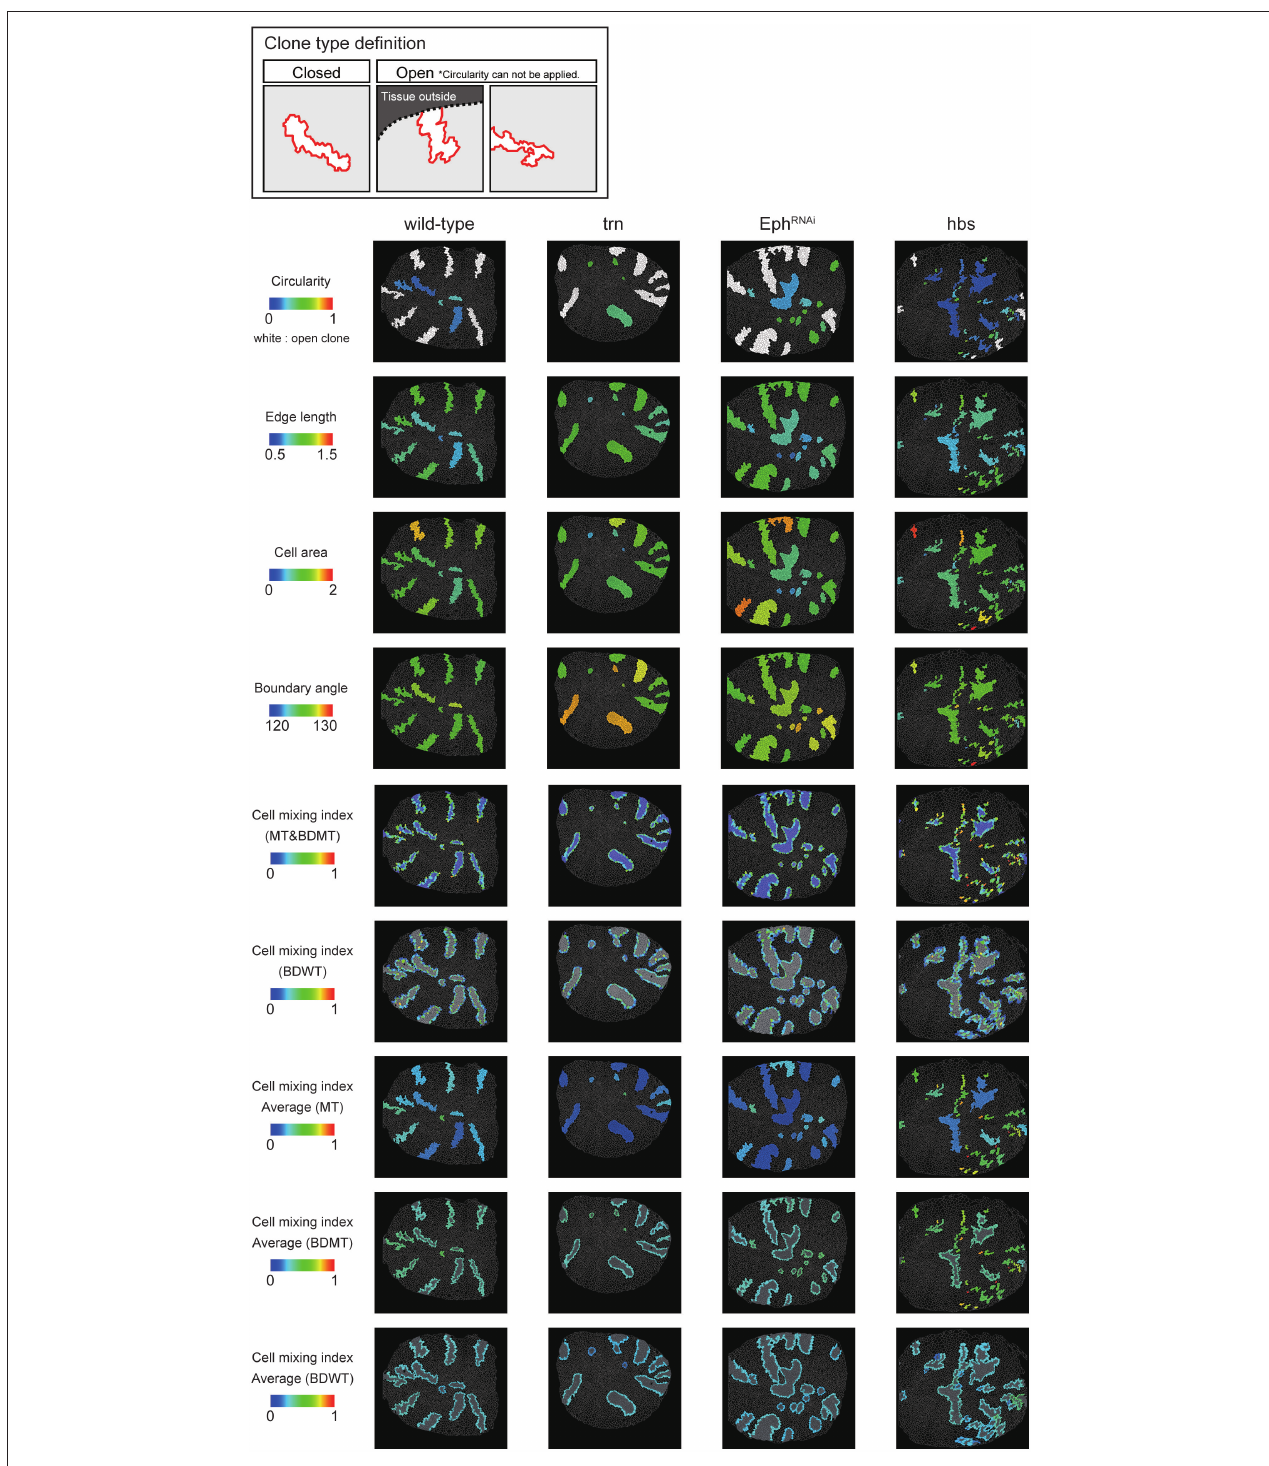
FIGURE 2 | Clone shape quantifications in wing discs. Uppermost panels: Definition of clone type. “Closed” clone is completely enclosed by wild-type cells (left), while “Open” clone contains an invisible portion due to its location at the distal region of the tissue (middle) or image frame (right). Visualization of individual criteria ( Figures 1C–J ) for the examined clones of four genotypes ( Figures 1L–O ). For open clones, circularity was not measurable, so they were filled by a white color.